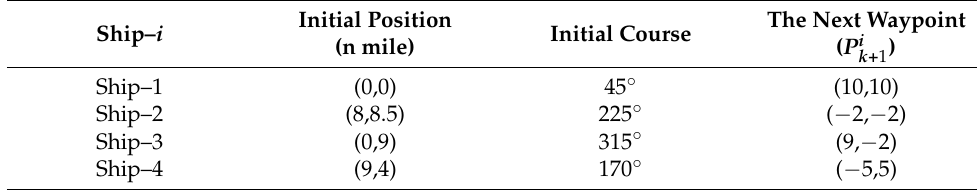
Table 1. The initial state of four ships in scenario 1.